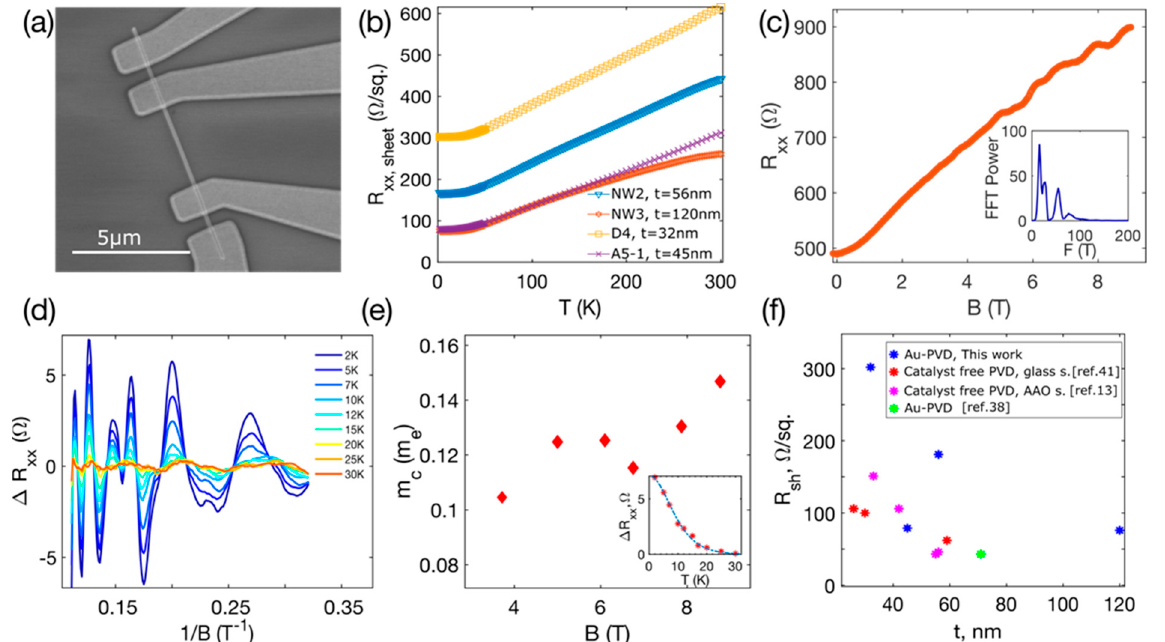
Figure 7. Magnetotransport in 3 nm Au-PVD Bi 2 Se 3 nanoribbons: ( a ) SEM image of Bi 2 Se 3 nanoribbon device used in transport measurements (nanoribbon A5-1); ( b ) sheet resistance R xxSheet ( = R xx w / L ) as a function of temperature. ( c ) Magnetoresistance R xx of the nanoribbon NW3 measured at 2 K. Inset: FFT spectra of Shubnikov–de Haas oscillations. ( d ) Shubnikov–de Haas oscillations with the subtracted background of the nanoribbon NW3, measured at temperatures 2–30 K. ( e ) Cyclotron mass versus magnetic field. Inset: oscillation amplitude as a function of temperature, dashed blue line is the LK fit yielding m c = 0.130 m e and the data correspond to the 2nd peak from the left in the ∆ R xx (1/B) plot. ( f ) Sheet resistance versus nanoribbon thickness for Bi 2 Se 3 nanoribbons synthesized using different approaches: catalyst-free PVD on a glass substrate, data from [41], catalyst-free PVD on anodized alumina (AAO), data from [13], Au-PVD, data from [38].